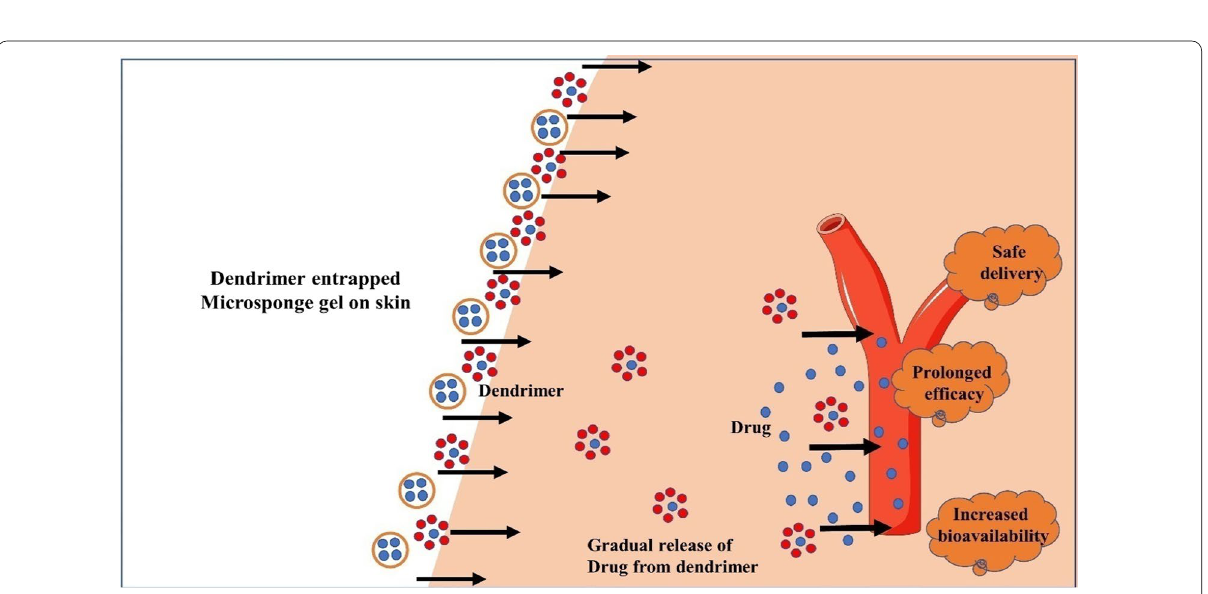
Fig. 15 Dendrimer-entrapped microsponge gel in